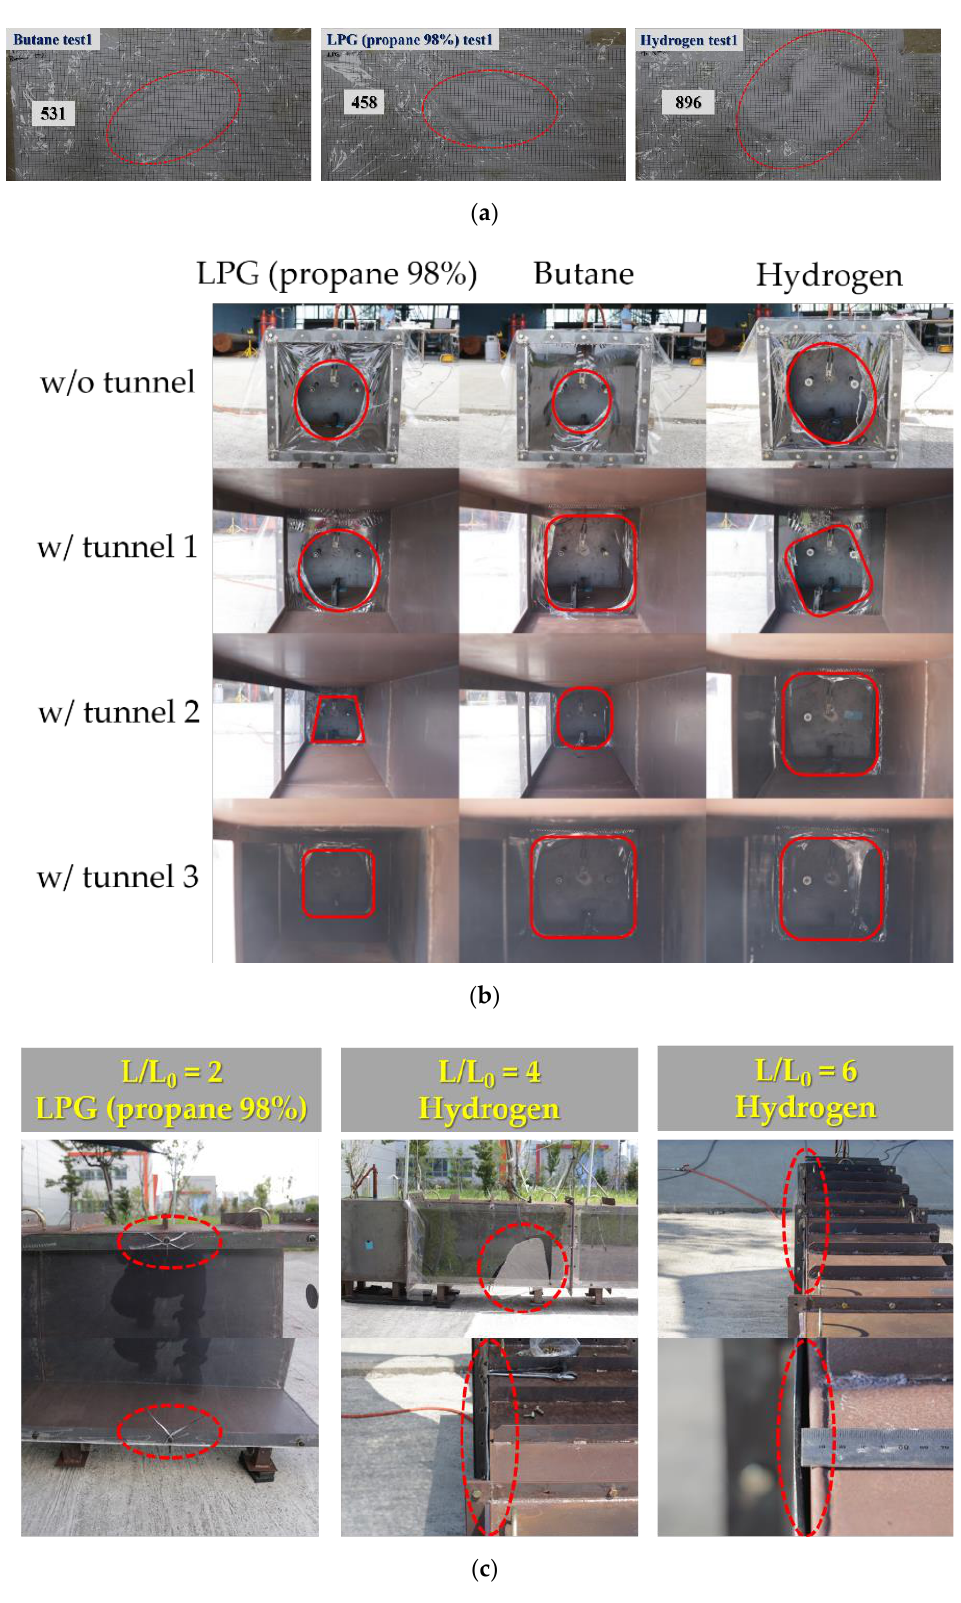
Figure 20. Plastic sheet rupture shapes during the explosion test with and without tunnels and broken observation window; ( a ) Plastic sheet rupture shape after explosion test without tunnel, ( b ) Plastic sheet rupture shape after explosion test without tunnel, and ( c ) Breakage of observation window after test.